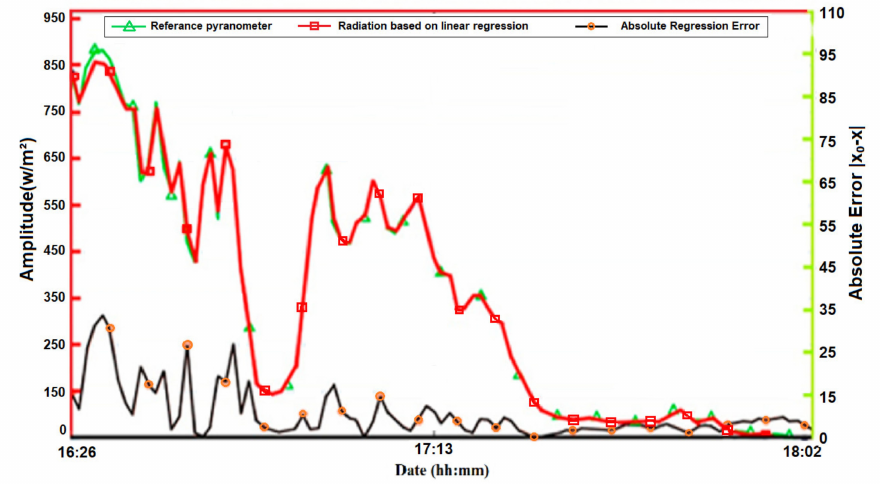
Figure 11. Photovoltaic panel